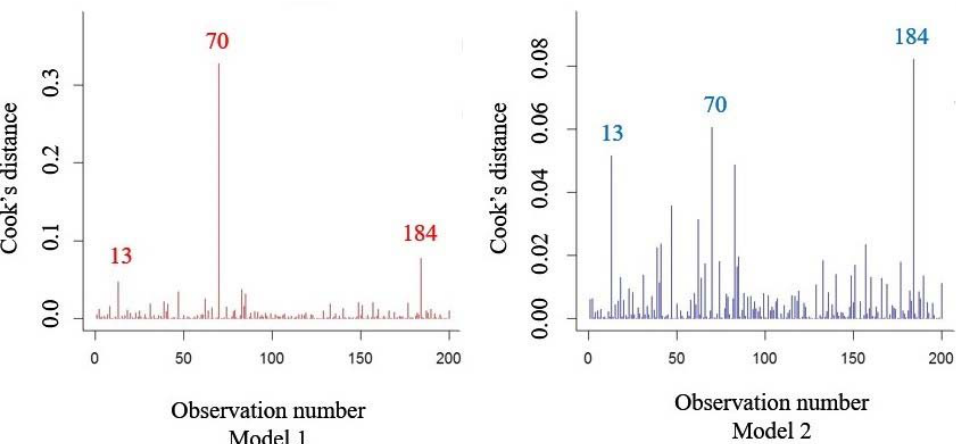
Fig. 8: Influence of observations on Models 1 and 2. Observations with a particularly high level of influence are numbered in red and blue.